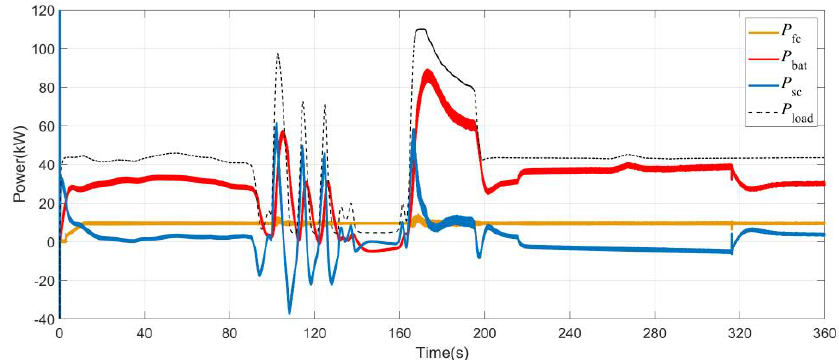
Figure 23. Power curve under the conventional vessel energy management strategy.